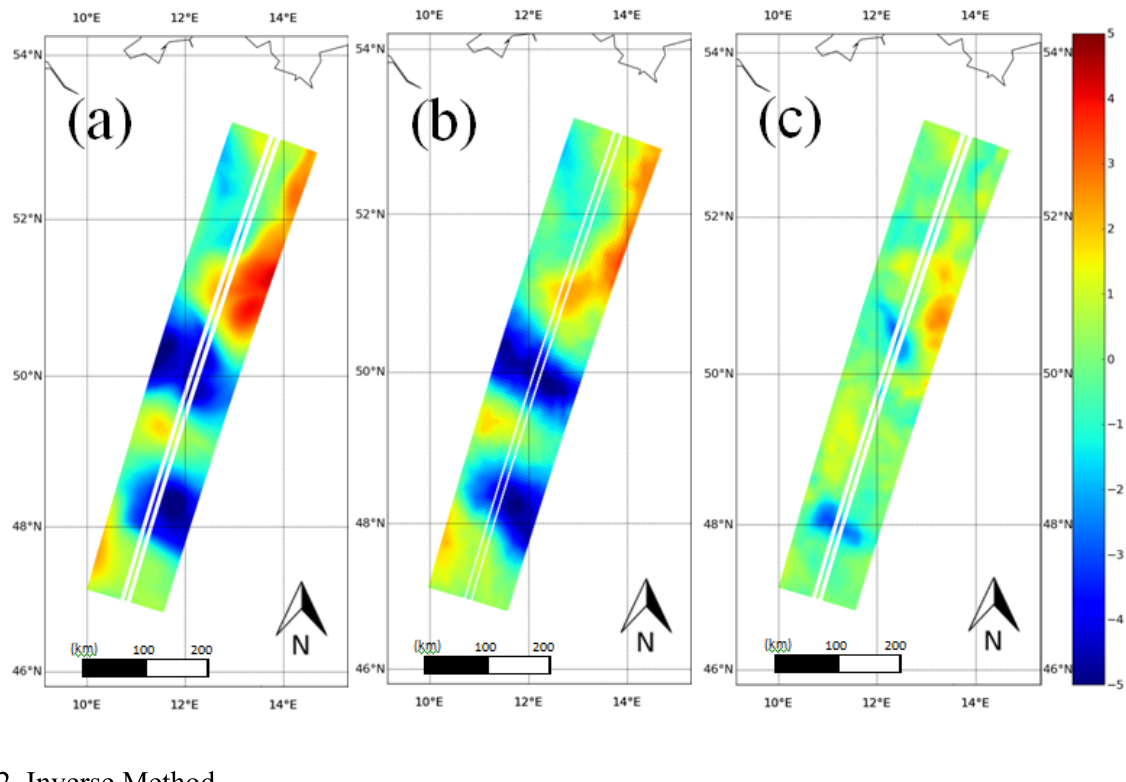
Figure 9. Usage of nadir altimetry and inverse method to mitigate absorption of oceanic variability in roll. ( a ) shows the “true” topography derived from the high-resolution ocean model. ( b ) shows the low resolution proxy estimated from nadir